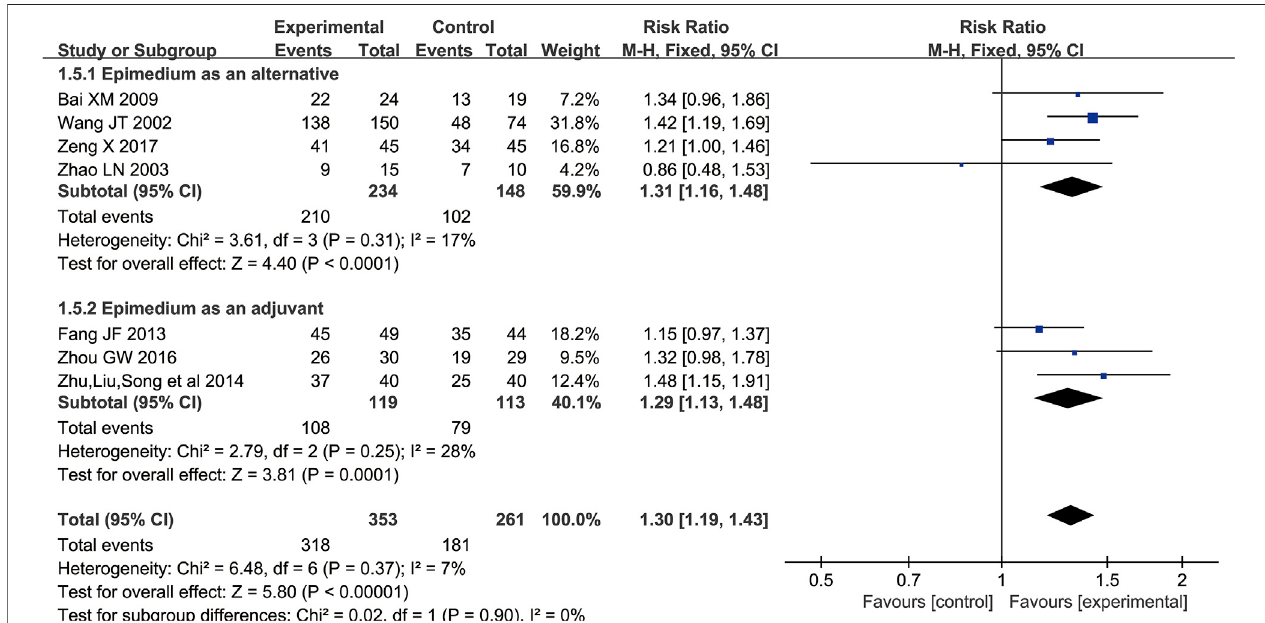
FIGURE 4 | Meta-analysis results of the effect of Epimedium vs conventional pharmacotherapy on clinical ef fi cacy.